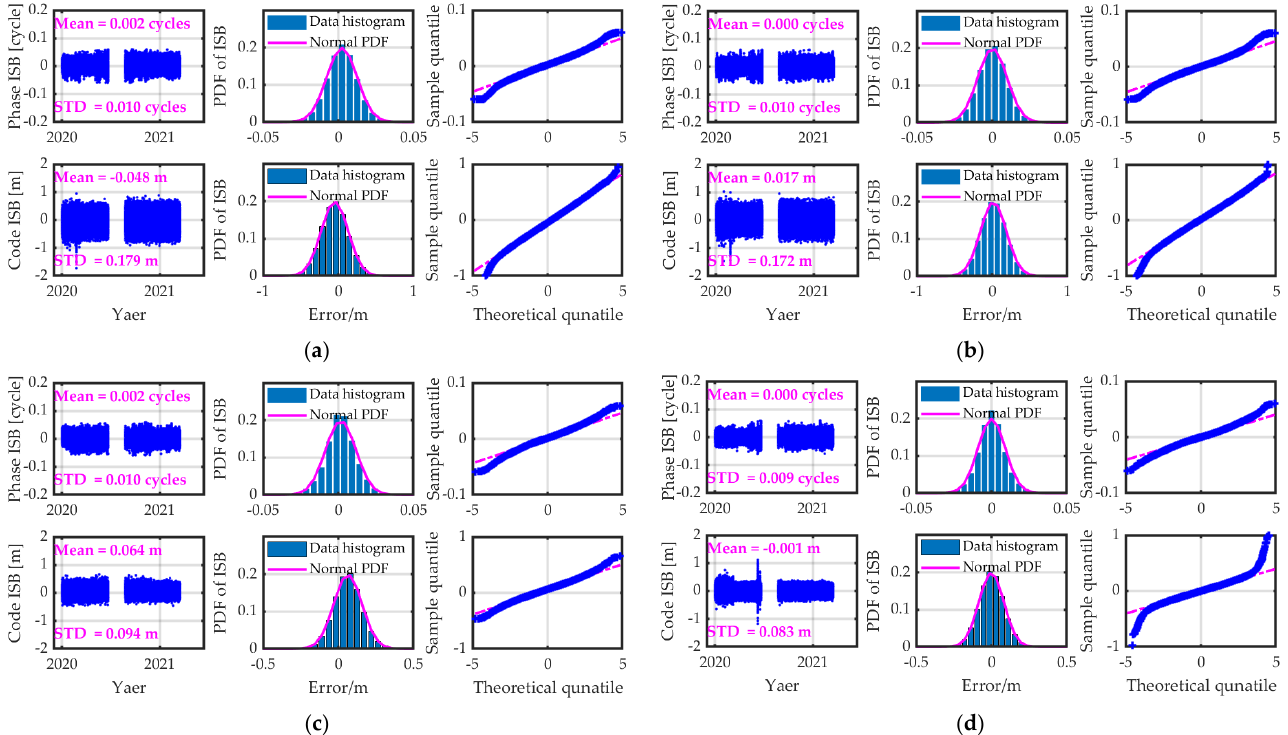
Figure 5. Time-series, probability density function (PDF) and quantile against the quantile (QQ) plot of both phase and code ISBs between B1C/L1 ( a ), B1C/E1 ( b ), B2a/L5 ( c ), and B2a/E5a ( d ) with the observations from DOY 29 to 70, 2021 between the baseline GODN-GODS with identical types of receivers. The magenta line in the PDF of ISB denotes the empirical normal PDF. The x -axis of the QQ plot denotes the quantile of the standard normal distribution, while the y -axis denotes the quantile of our sample distribution as shown in the time series. The dotted line in the QQ plot denotes the empirical normal distribution of the sample against the standard normal distribution, while the scatters denote the real sample